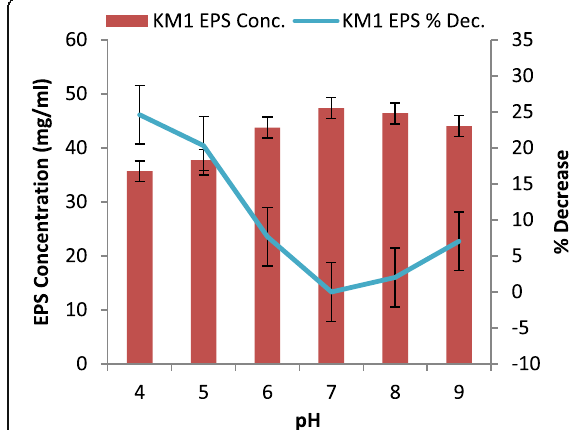
Fig. 4 Effect of pH on purified EPS concentration